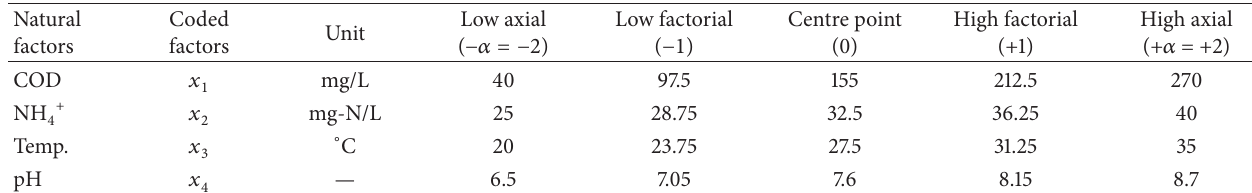
Table 2: The natural and coded parameters.